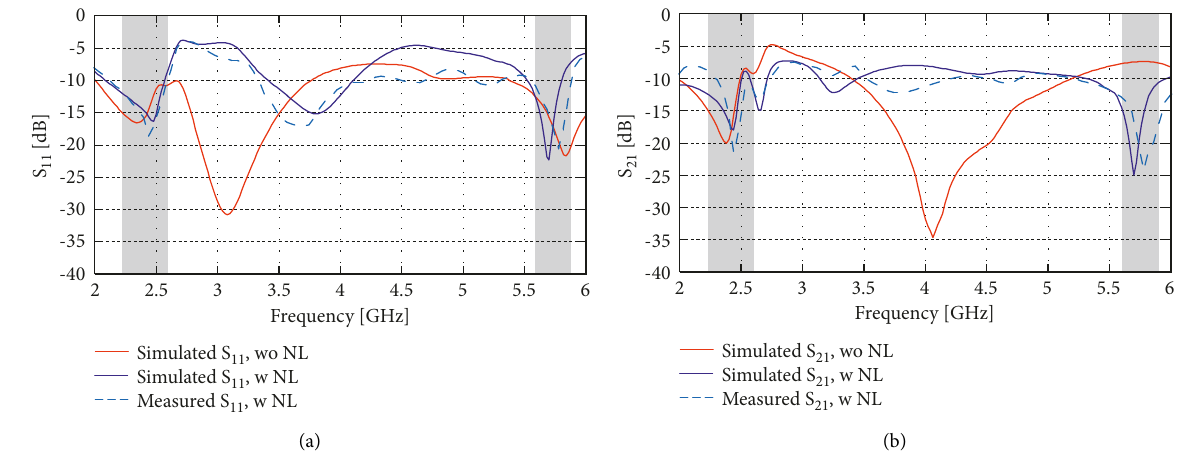
Figure 9: S-parameters of antenna#2 with and without NL: (a) S